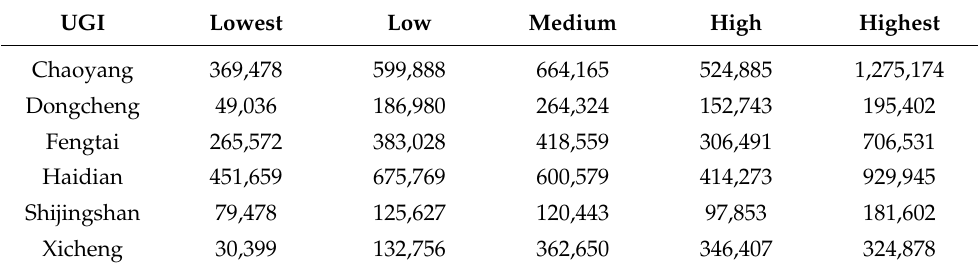
Figure 12. ( a ) Spatial distribution of the hot and cold spots of UGI and ( b ) population density in the center of Beijing in 2020. Table 7. Population statistics of different districts with different UGI